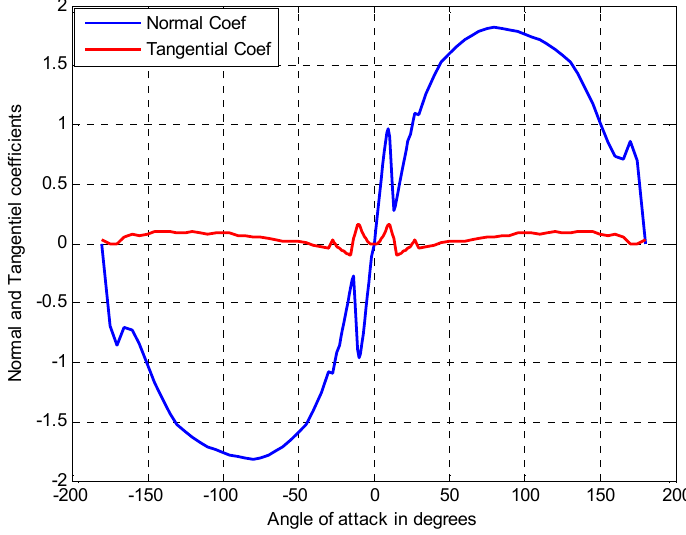
Figure 15. Normal and tangential coefficient variations as functions of the angle of attack.